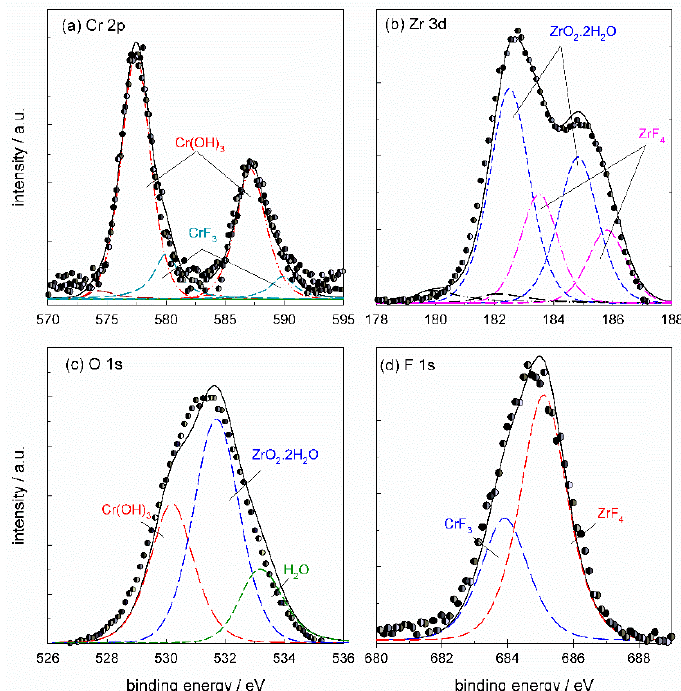
Figure 17. Deconvoluted high-resolution XPS spectra of ( a ) Cr 2p , ( b ) Zr 3d , ( c ) O 1s and ( d ) F 1s recorded for chemically pre-treated AA3003 sample coated using conversion coating ST650 prepared at 10% concentration and conversion time 18 min at room temperature. Experimental spectrum (symbols), fitted curve (solid line), component peaks (dashed lines).